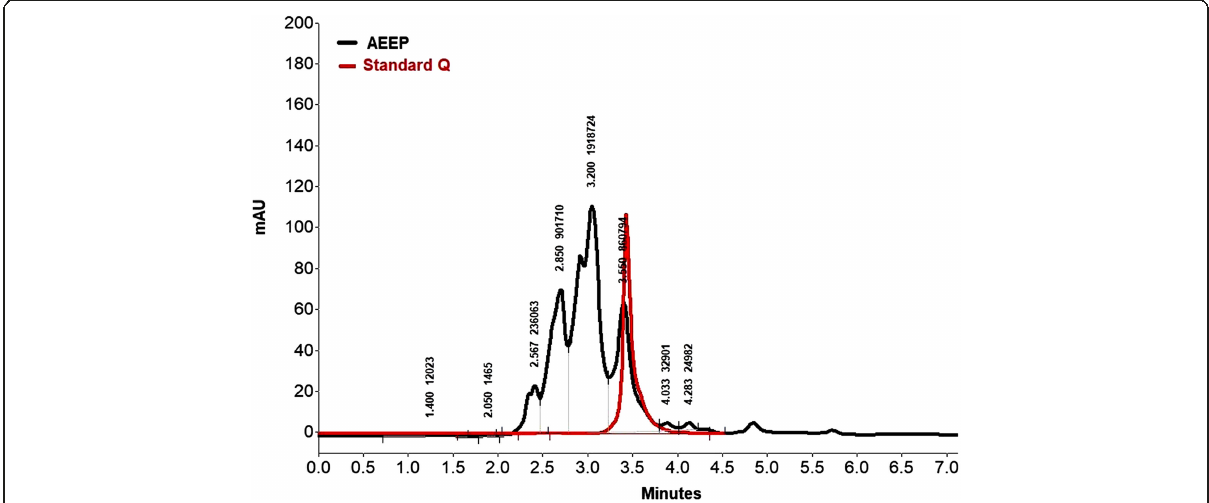
Fig. 1 HPLC analysis of quercetin (red graph) and ethanolic extract of propolis (AEEP) that represented in black color